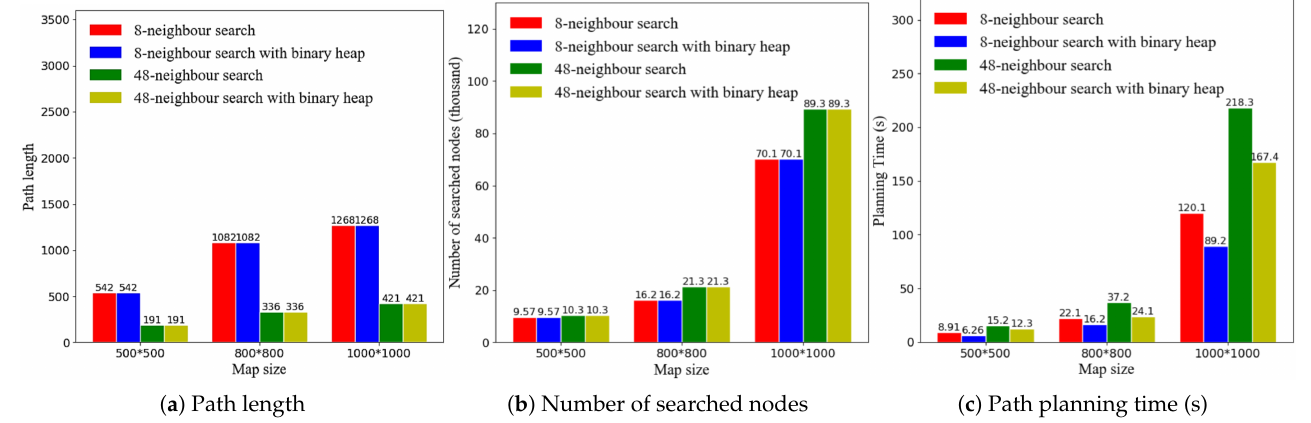
Figure 14. Efficiency evaluation of minimum binary heap.